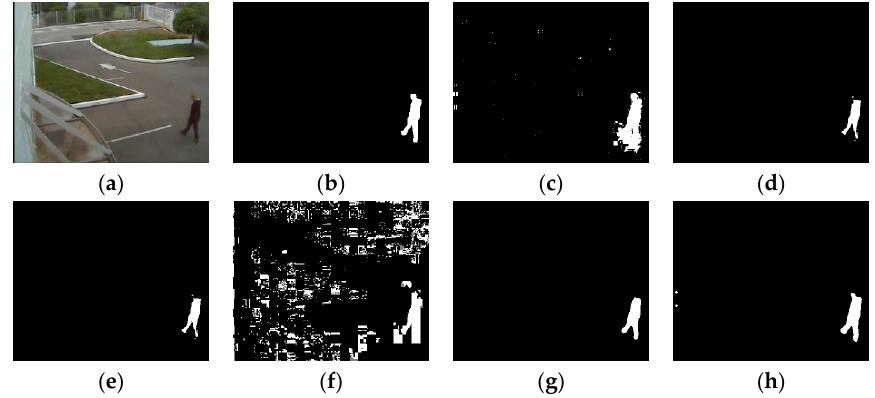
Figure 8. ( a ) is the frame 15553 of input images; ( b ) ground truth; ( c ) GMM (Gaussian Mixture Modeling); ( d ) ViBe (Visual Background extractor); ( e ) GMG (an algorithm for finding the Global Minimum with a Guarantee);( f ) KDE (Kernel Density Estimation); ( g ) LBAdaptiveSOM (Local Background Adaptive Self-Organizing Modeling); ( h ) our method.